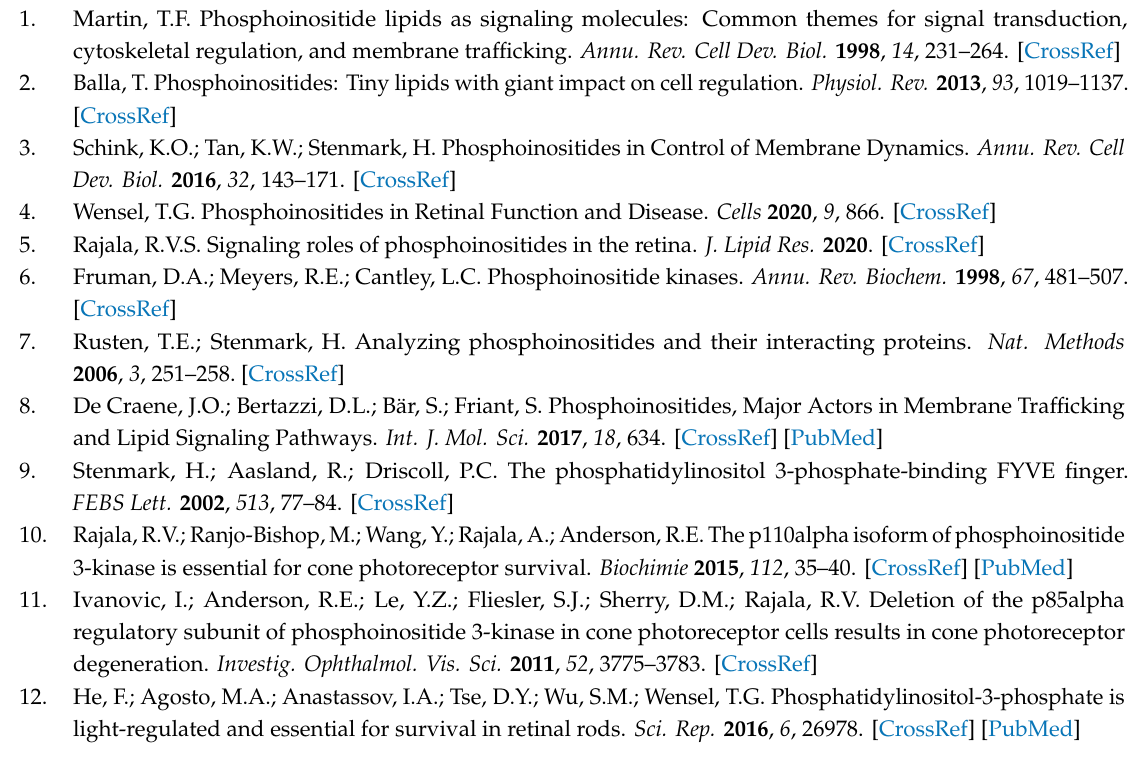
Figure S1: Expression of S-opsin in Vps34-floxed and CC-Vps34 KO mice. Figure S2: Expression of M-opsin in Vps34-floxed and CC-Vps34 KO mice. Figure S3: Morphology of cone-specific Vps34 KO retina and assessment of rod outer segment integrity. Figure S4: Expression of glial fibrillary acidic protein (GFAP) and glutamine synthetase (GS) in cone-conditional Vps34 KO mice. Figure S5: Original